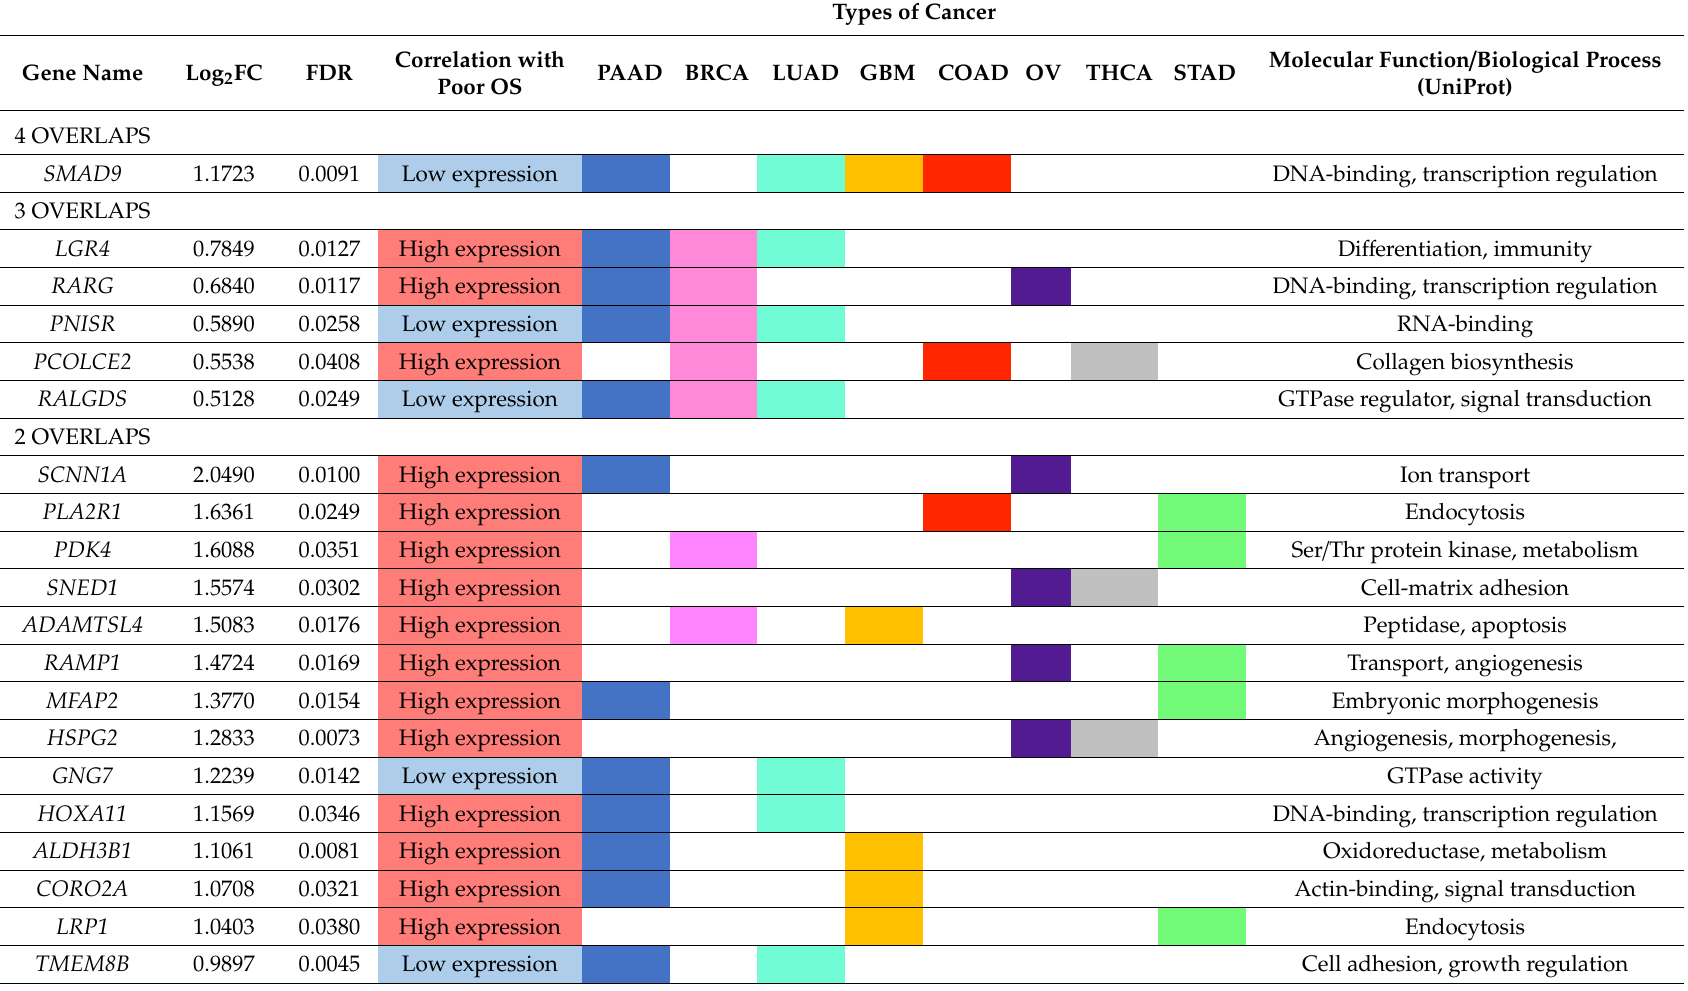
Table 1. Acid adaptation-upregulated genes significant in OS analysis in at least two types of cancers. Types of